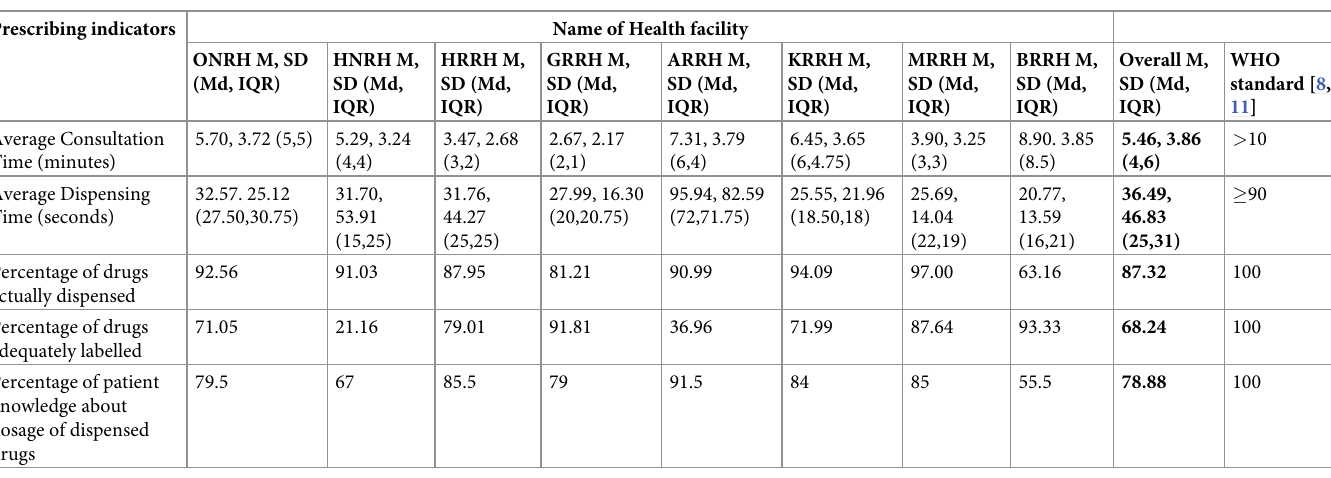
Table 5. Patient care indicators vis- à -vis WHO core standards.